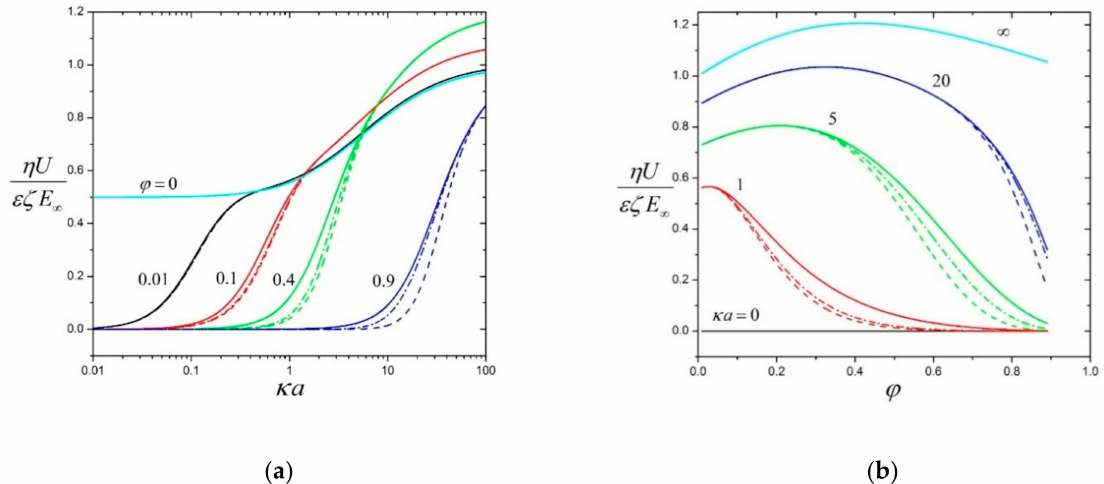
Figure 5. The normalized electroosmotic velocity η U / εζ E ∞ of an electrolyte solution through a fibrous medium calculated from Equation (26a) for the Happel/Levine-Neale cell model versus the parameters κ a ( a ) and ϕ ( b ). The solid, dot-dash, and dashed curves represent the cases of the charge regulation parameter La equal to 0, 5, and ∞ ,